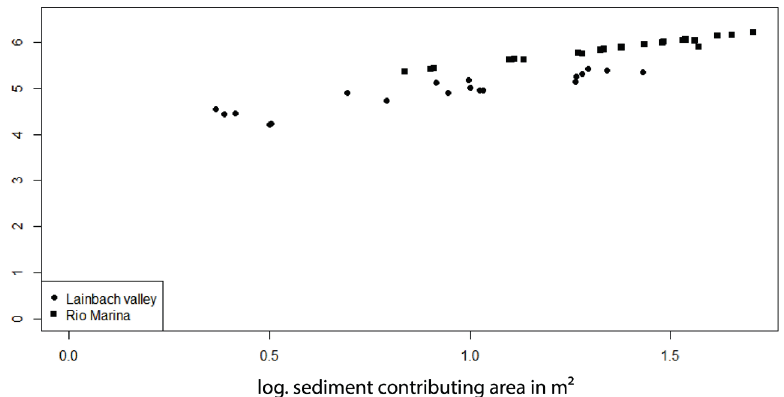
Comparison of TLS and UAV data using